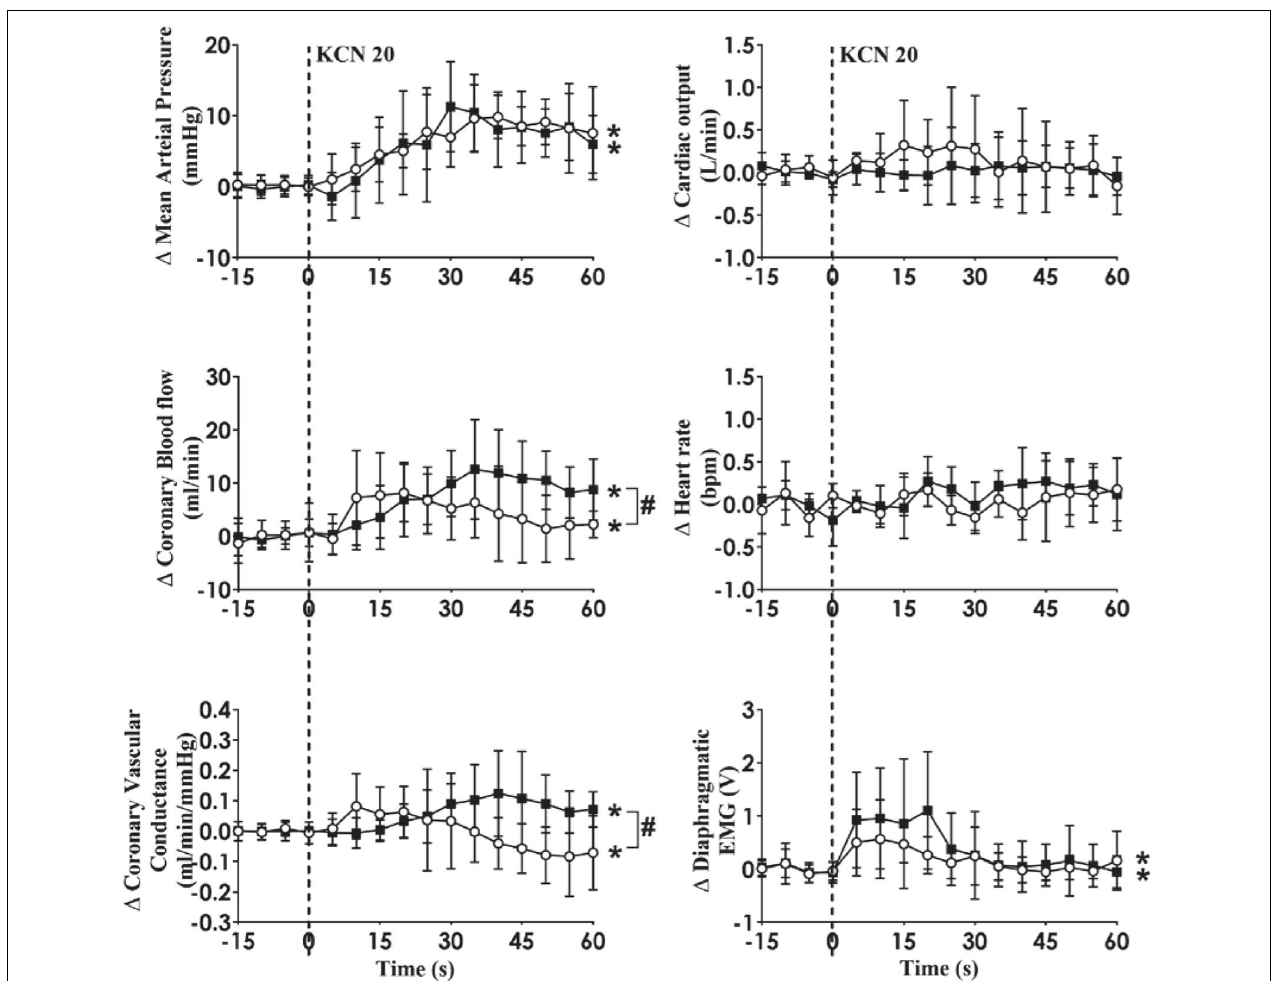
FIGURE 4 | Absolute change in mean arterial pressure, coronary blood flow, coronary vascular conductance, cardiac output, heart rate, and dEMG in response to intra-carotid potassium cyanide (KCN; 20 mg/kg) injection in control ( n = 6) and heart failure ( n = 6) sheep. The heart was paced at a constant rate such that the heart rate was unchanged. The open circles and solid line represent control, and filled squares and solid line represents HF animals. Results are mean ± SD. * p < 0.05 denotes a significant effect of time (ANOVA, *effect within 1 min time after injections; # significant interaction effect of time × group). TABLE 2 | The effect of intravenous atropine infusion on resting hemodynamic variables. Control Heart failure Basal After atropine Basal After